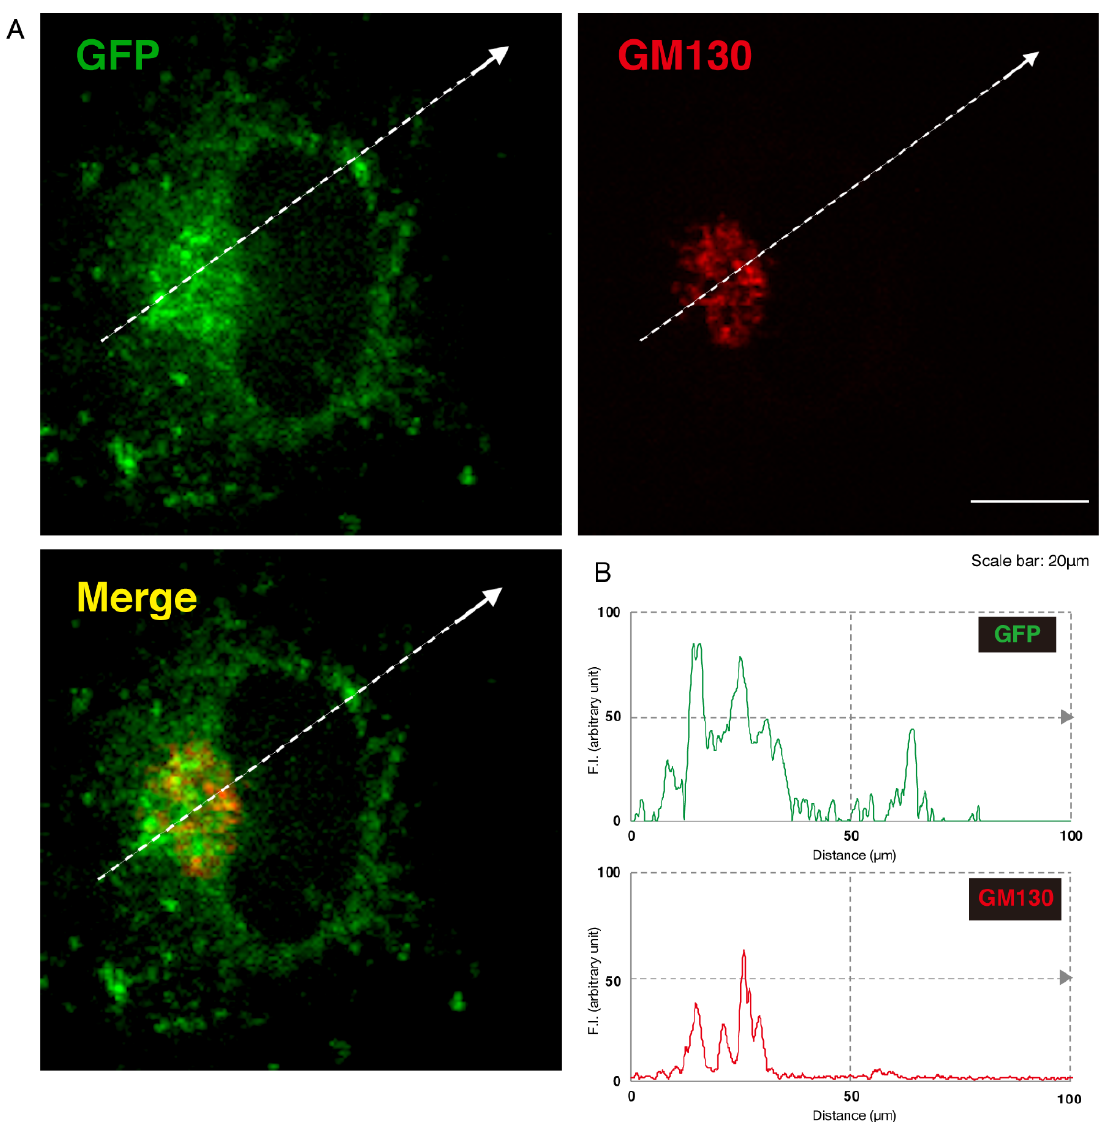
Figure 5. The Q39X mutant proteins are partially colocalized with the Golgi body marker. ( A ) N1E-115 cells were transfected with the plasmid encoding the Q39X mutant construct of GFP-tagged AIMP1 (green). Transfected cells were stained with an antibody against the Golgi body marker GM130 (red). A merged image with a dotted arrow is also shown in the bottom panel. The scale bar indicates 20 µ m. ( B ) Fluorescence intensities (F.I., arbitrary unit) of green and red colors are shown along dotted arrows in A.